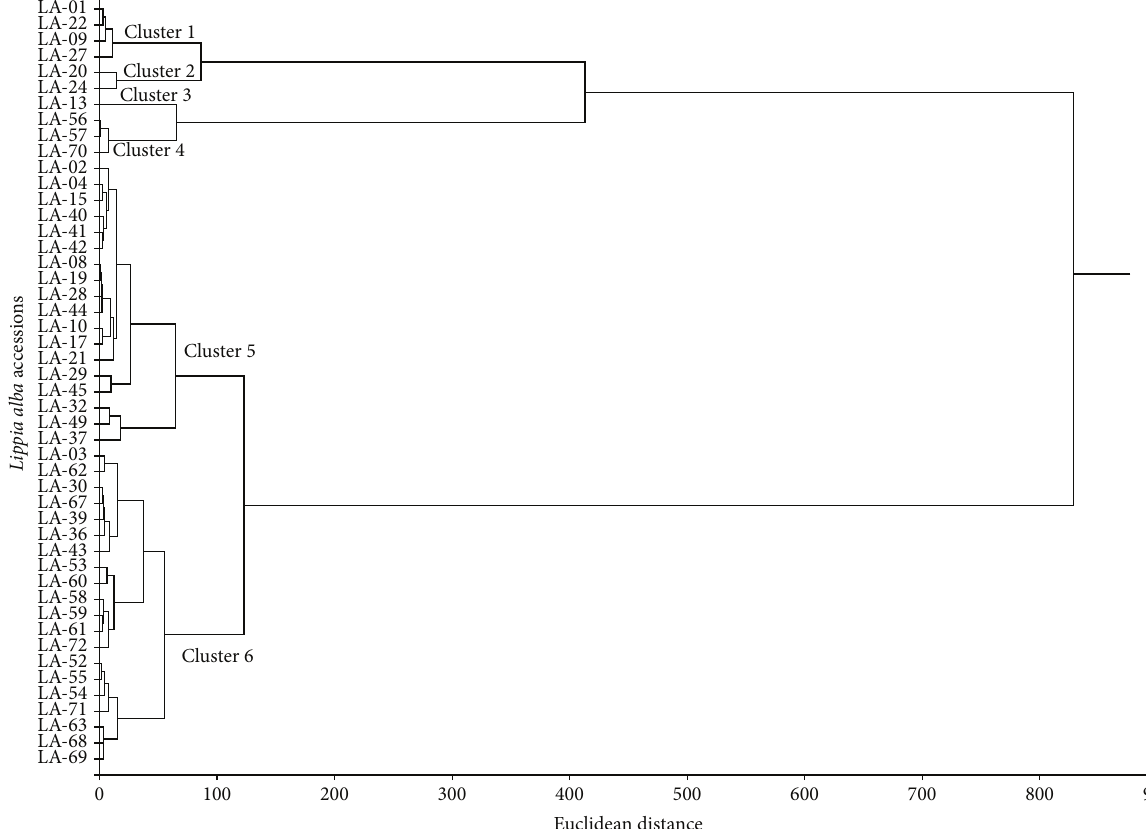
Figure 1: Two-dimensional dendrogram showing the similarity of the chemical compositions of 48 L. alba accessions obtained from the Active Germplasm Bank at the Federal University of